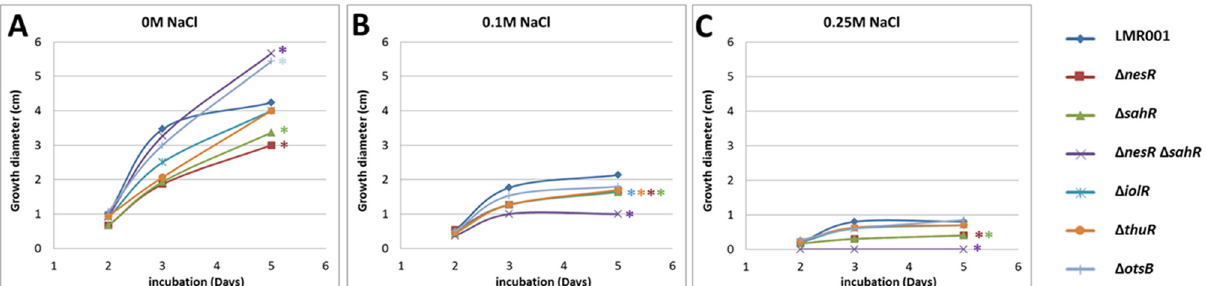
Figure 5. Effects of the mutations and osmotic strength on bacterial swimming. The motility was estimated by measuring the growth diameter from triplicate TY soft agar plates supplemented with salt 0 M ( A ), 0.1 M ( B ) or 0.25 M ( C ). The mean motility after 2, 3, and 5 days are shown for the LMR001 and the 6 mutants (indicated on the right of the figure). Significant differences with LMR001 motility after 5 days ( p -value < 0.05, Tukey’s Test) are indicated by “*” on the right of lines using the same color